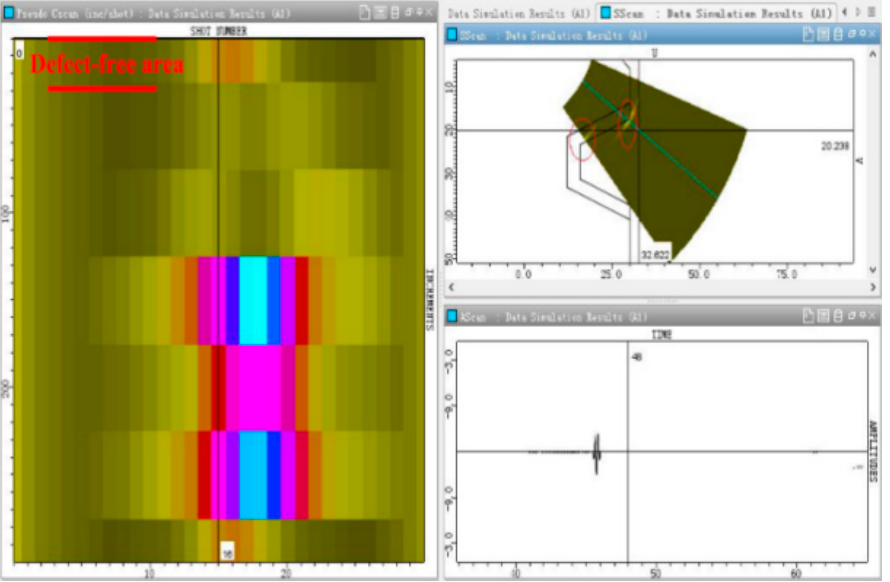
Figure 11. Simulation analysis of structural signal echo in the position without defect of the specimen.